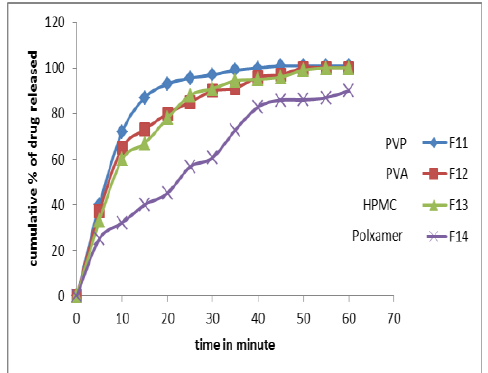
Figure (2): Effect of polymer type on the dissolution profile of ezetimibe nanoparticles from F11, F12, F13, and F14 in 0.1 N HCL solutions (pH 1.2) containing 2% brij-35 w/v at 50 r.p.m and 37˚C temperature.